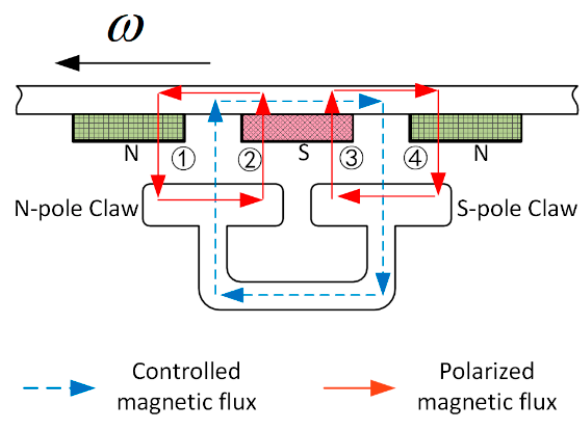
Figure 3. The planar magnetic circuit of CPMLTM. As an EMC for hydraulic valves, the accuracy and ease of their neutralization (align- ment performance) is important to the performance of hydraulic valves and even hydraulic systems. The structure of a conventional moving-iron torque motor is shown in Figure